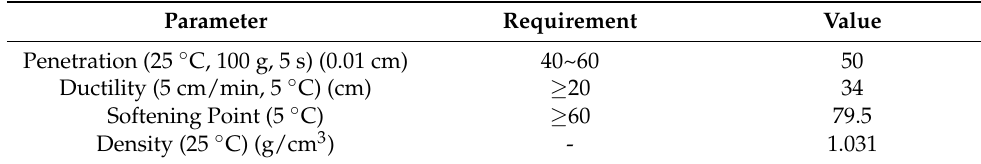
Table 4. Technical indicators of bituminous binder.